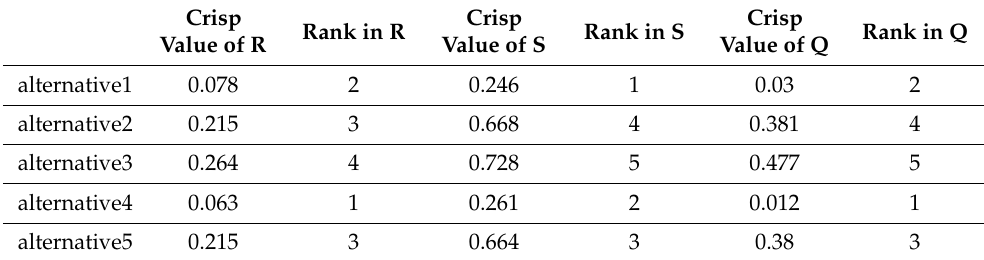
Table 7. The crisp values S, R, Q and ranking of alternatives.